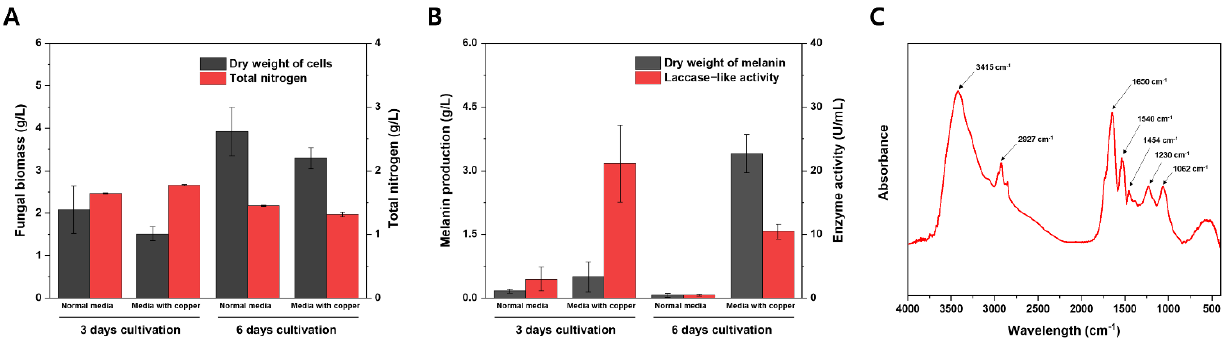
Figure 6. Effect of copper addition on A . resinae cultivation profile. ( A ) Fungal biomass and total nitrogen concentration of media. ( B ) Melanin production and laccase-like activity in the culture filtrate. ( C ) FT-IR spectrum of melanin synthesized using the culture filtrate and L-DOPA.